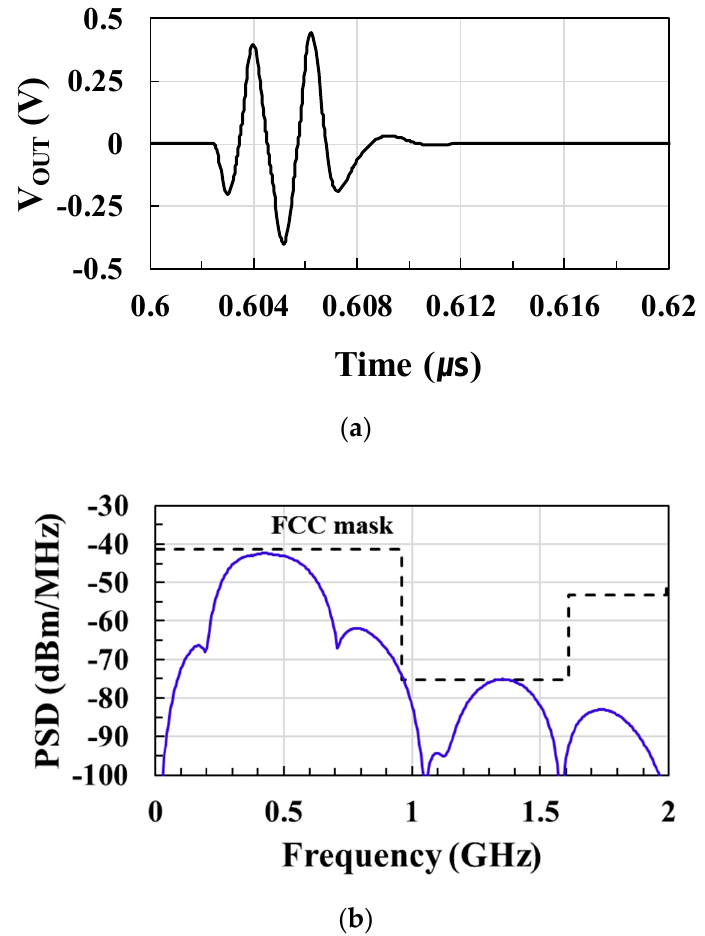
Figure 14. ( a ) Output pulse waveform of the UWB transmitter; ( b ) output power spectral density (PSD) of the UWB transmitter.